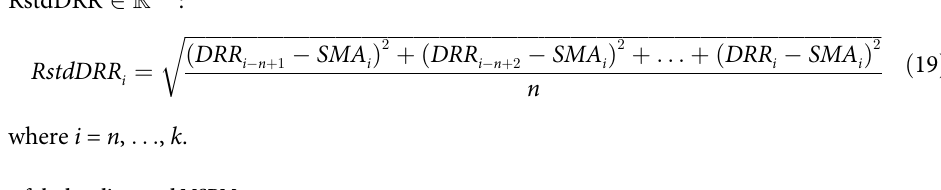
Table 3. Comparison of back-testing performance of the baselines and MSPM. Portfolio